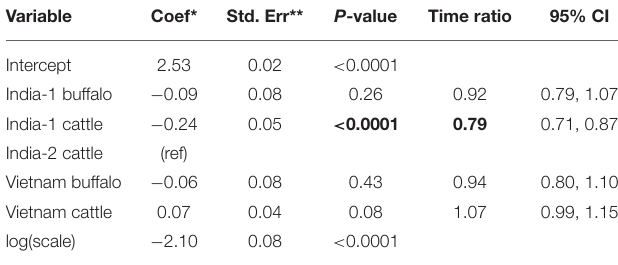
The model was fitted using the log-logistic distribution. Significant values are indicated in bold. model, the odds of persistent infection at any given time were Vietnam cattle compared to India-2 cattle ( p = 0.02 and p =